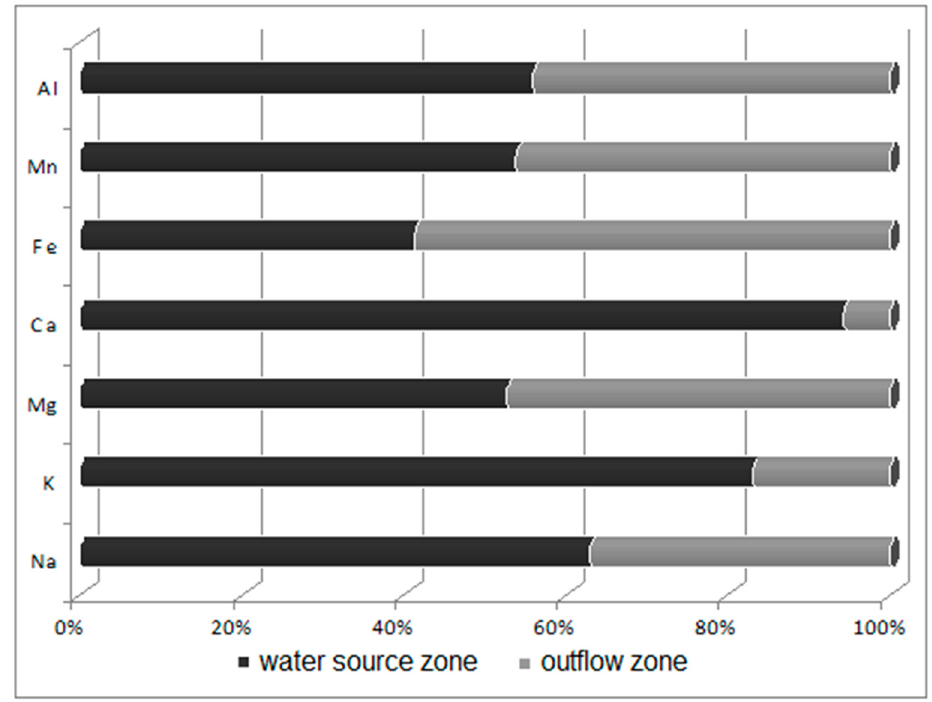
Figure 4. Ratio of sediment macroelement concentrations in the water source zone to those in the outflow zone.